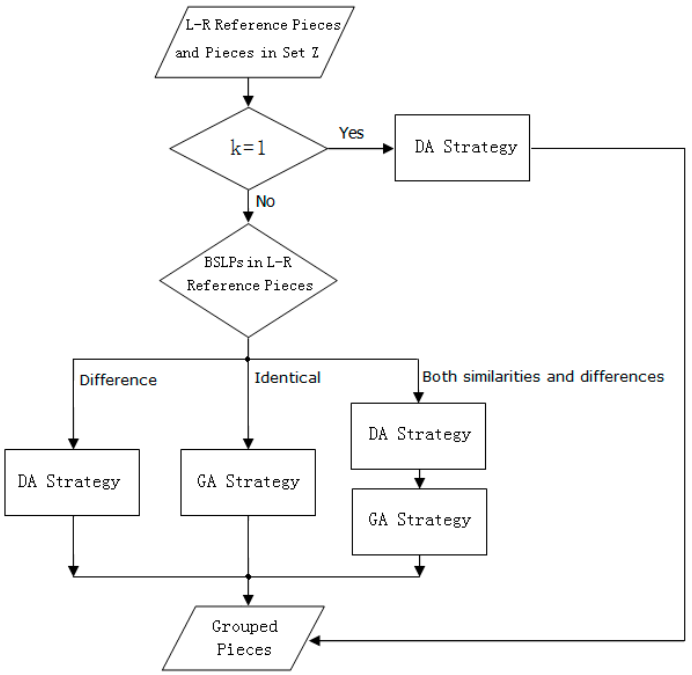
Figure 16. Algorithm flowchart of reference grouping .